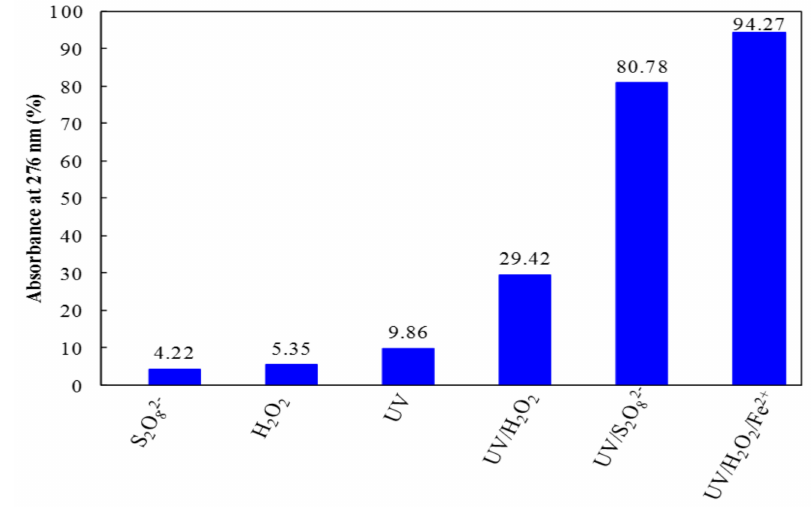
Figure 2. Comparison of TA degradation for 120 min reaction time by different processes including S 2 O 82 − alone ([S 2 O 82 − ] = 53.1 mM), H 2 O 2 alone ([H 2 O 2 ] = 29.4 mM), UV irradiation alone ( λ = 254 nm), UV/H 2 O 2 ( λ = 254 nm, [H 2 O 2 ] = 29.4 mM), UV/S 2 O 8 2 ( λ = 254 nm, [S 2 O 8 2 − ] = 53.1 mM), and UV/H 2 O 2 /Fe 2+ ( λ = 254 nm, [Fe 2+ ] = 0.18 mM and [H 2 O 2 ] = 29.4 mM). Experimental conditions: [TA] = 0.1 mM, initial pH (pH = 3.4), T = 25 ◦